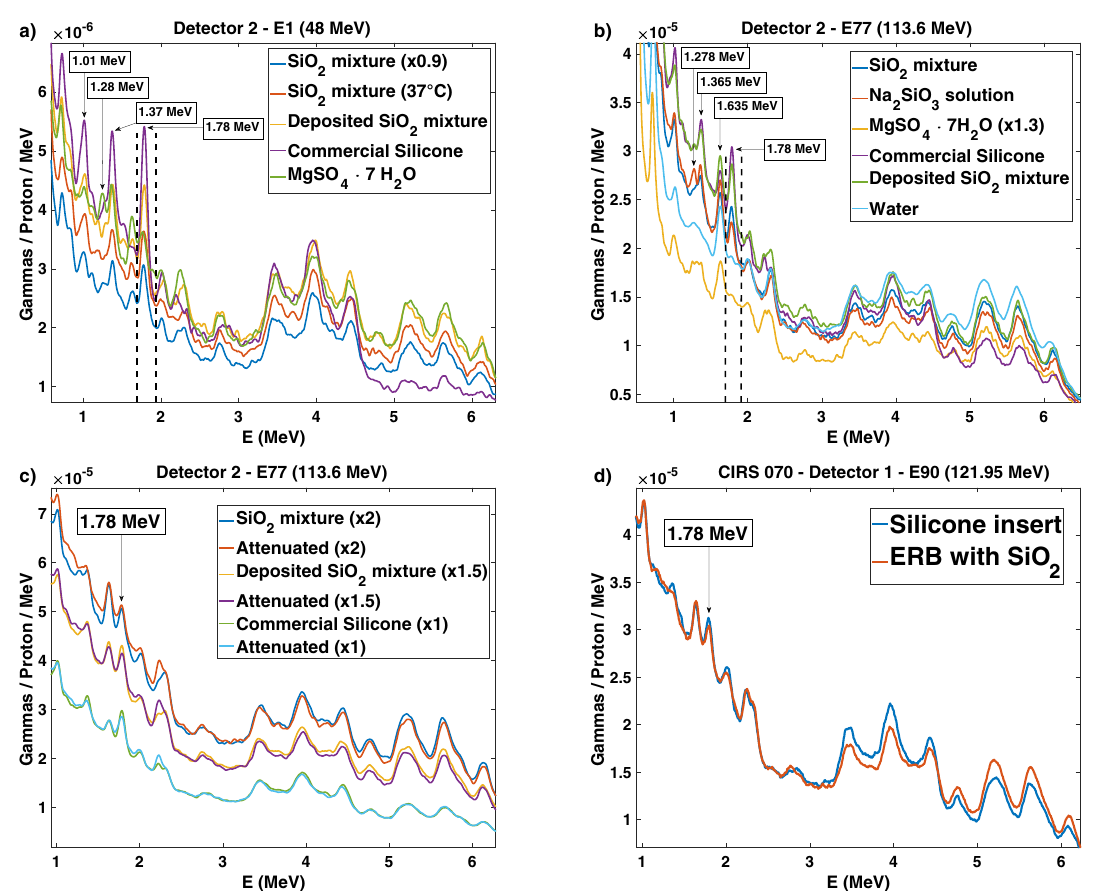
Figure 2. Energy spectra obtained from the irradiation of several targets by protons. ( a ) The targets irradiated with the minimum proton energy exhibit very prominent silicon energy peaks. A sulphur energy peak at 1.28 MeV is also visible. ( b ) Targets located after two flasks of water were irradiated with an energy of 113.6 MeV. The silicon energy peak at 1.78 MeV exhibits relatively low prominence for all materials and is absent for water. A sodium energy peak at 1.278 MeV is also visible. ( c ) The effect of the prompt gamma attenuation by the two flasks of water on each side of the target in the path to the detectors is shown for the three targets. ( d ) The commercial silicone insert and the balloon with the mixture of SiO 2 inserted in the prostate phantom present similar spectra under irradiation by proton beams of 121.95